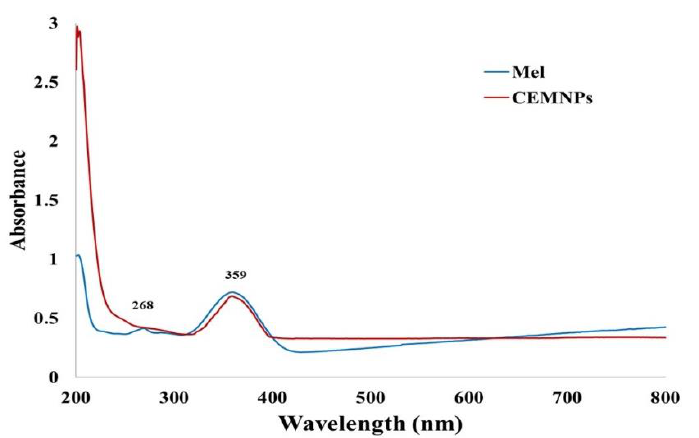
Figure 4. UV spectrum of meloxicam and chitosan-encapsulated meloxicam nanoparticles (CEMNPs).